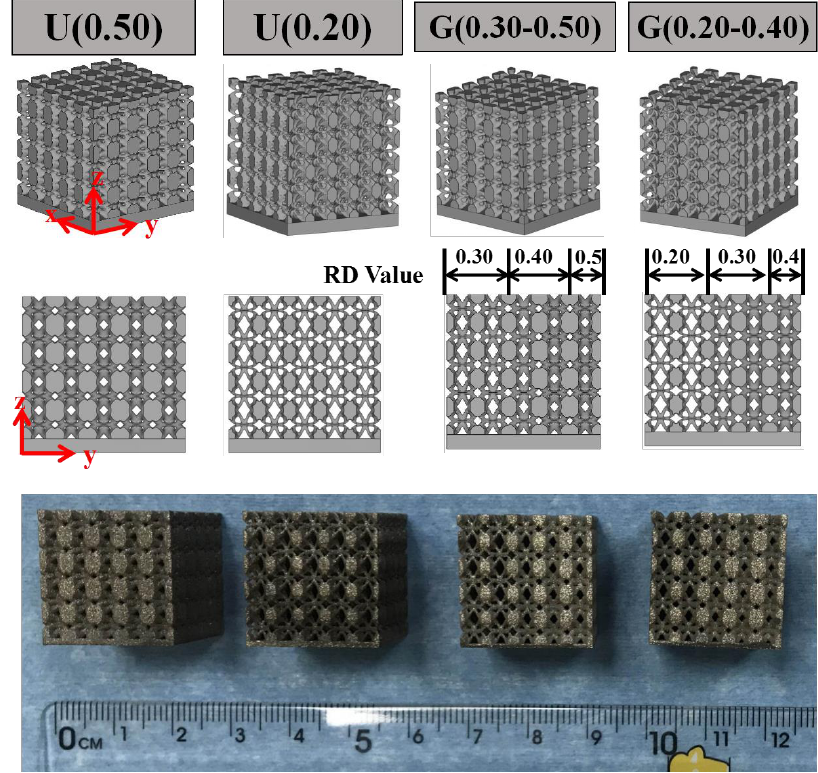
Figure 2. The CAD models and SLM fabrication of designed lattice